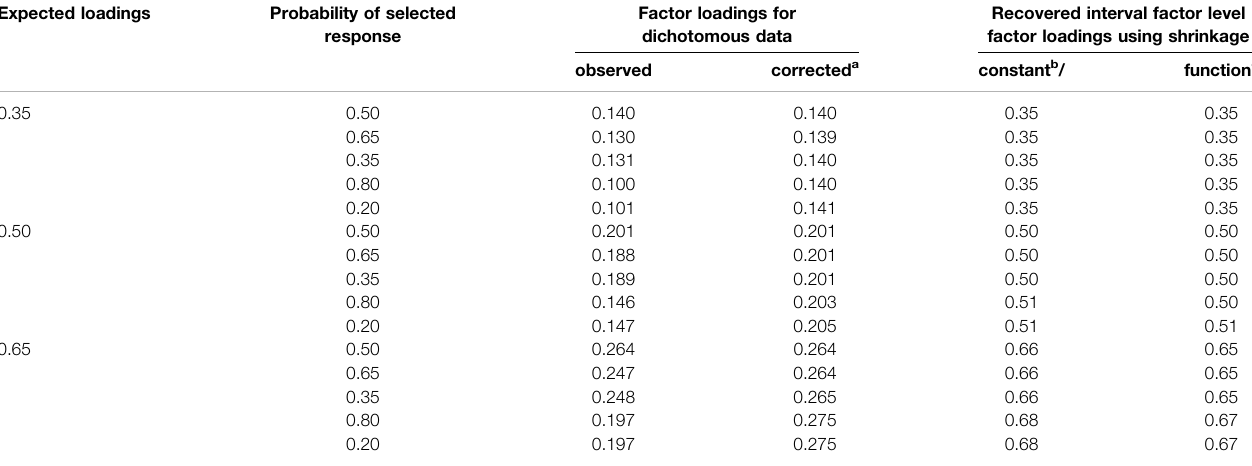
TABLE 5 | Observed and Probability-corrected Factor Loadings for Dichotomous Data as Well as Recovered Factor Loadings for Interval-level Data (400 Datasets). Expected